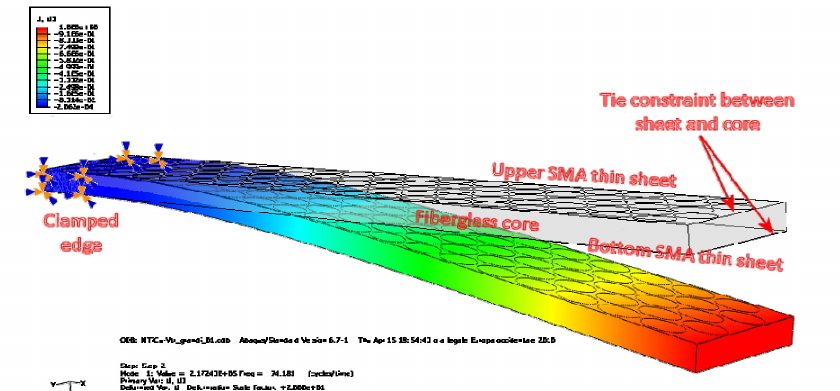
Figure 9: FEM model of the hybrid composite and first flexural deformed shape with superimpose the vertical displacement when the displacement of the free end is 1